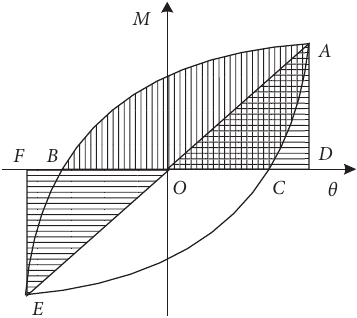
Figure 23: Computing model for equivalent viscous damping